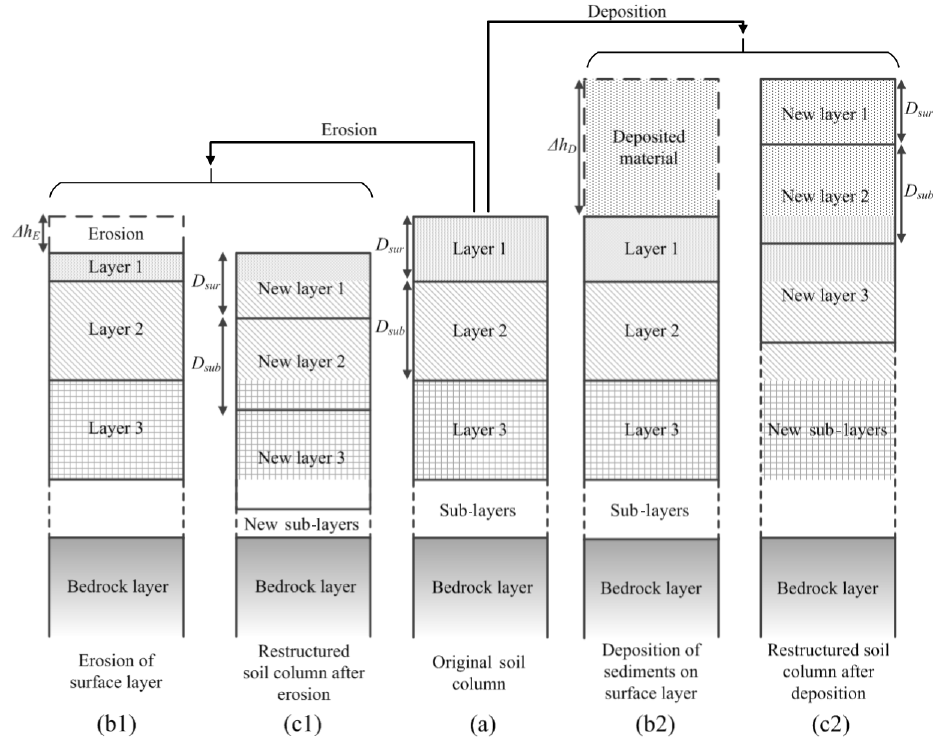
Figure 2. Erosion, deposition, and the restructuring of the soil profile: (a) original soil profile, ( b1, c1 ) for erosion, and ( b2, c2 ) for